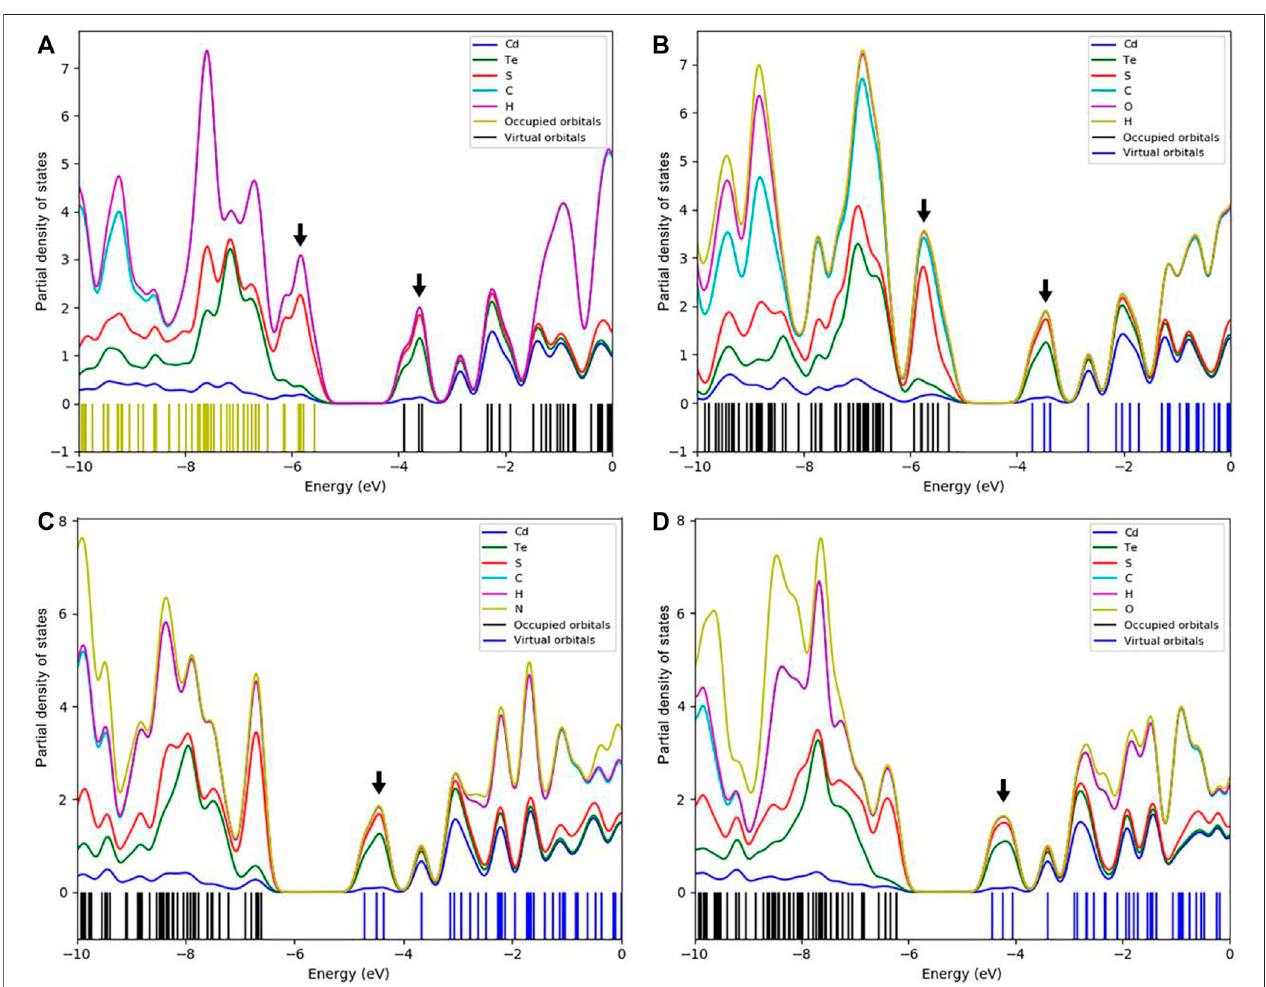
FIGURE7| Thepartialdensityofstates(PDOS)plots(stacked)neartheHOMO/LUMOgapsforthecappedCd 6 Te 6 (TP) 6 (A) ,Cd 6 Te 6 (MBT) 6 (B) ,Cd 6 Te 6 (MBN) 6 (C) and Cd 6 Te 6 (MBA) 6 (D) QDs calculated with B3LYP/Lanl2DZ approach.